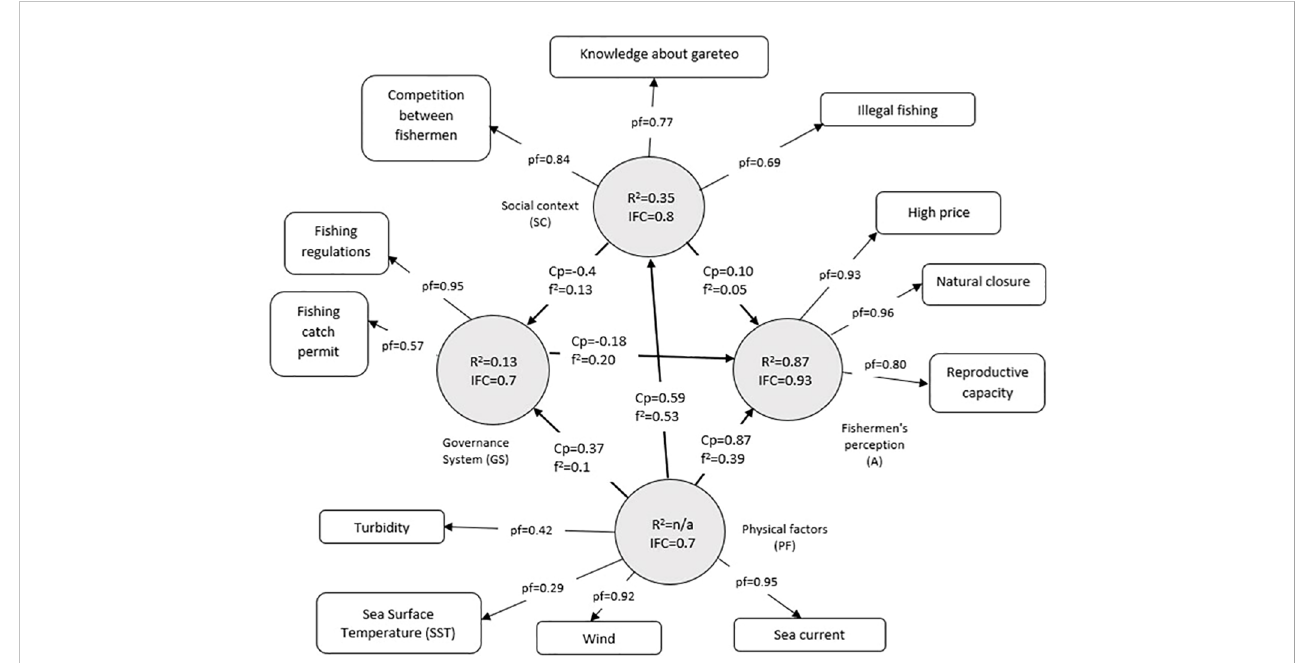
FIGURE 2 Estimation of the structural (grey) and measurement (white) model; each circle represents a latent variable, and a rectangle represents the observable variables; Determination coef fi cient (R 2 ), Composite Reliability Index (IFC), Path coef fi cient (Cp), effect index in R 2 (f 2 ), loads or factorial weights (pf); analysis method using PLS algorithm; own elaboration based on SmartPLS software.